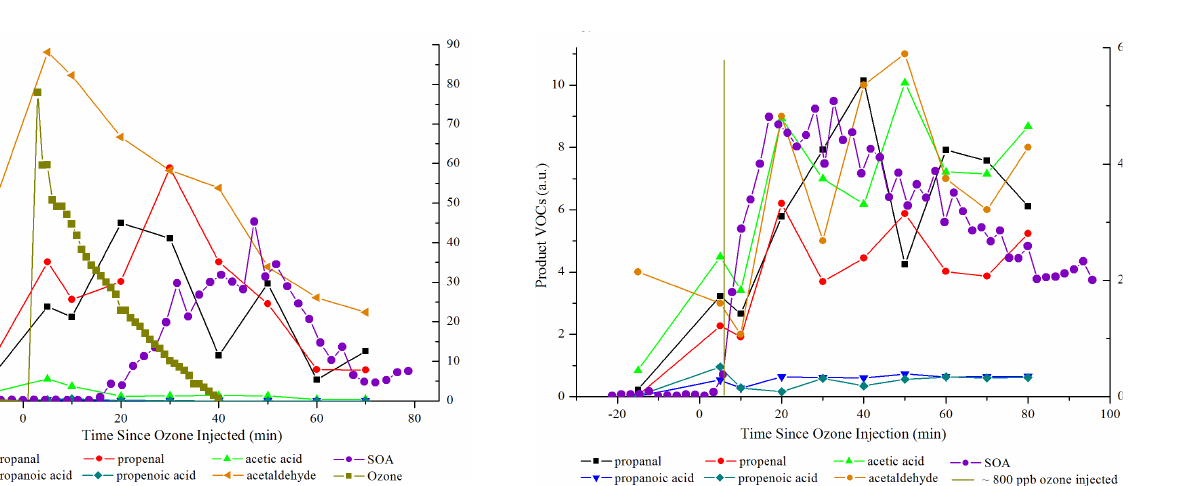
Fig. 7b. In addition to the evolution of SOA, the ozonolysis of grass headspace resulted in the evolution of several volatile products, in- cluding propanal, propenal, propenoic acid, acetic acid, propanoic acid, acetaldehyde, several of which have not previously been re- ported as products of CHA or HXL ozonolysis. Lines between data points drawn to aid the